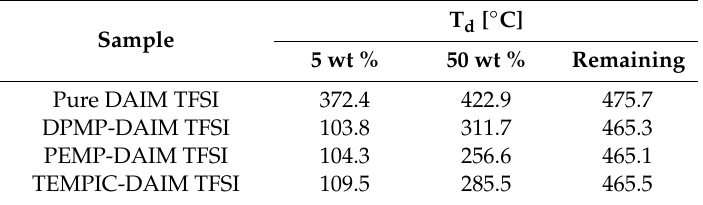
Figure 4. TGA thermograms of DPMP-DAIM TFSI, PEMP-DAIM TFSI, TEMPIC-DAIM TFSI ionic and pure DAIM TFSI, solvent: Li-TFSI / PC (1 M), monomer concentration: 30 wt %. Table 2. Thermal properties of ionic gels by Table 2. Thermal properties of ionic gels by TGA.